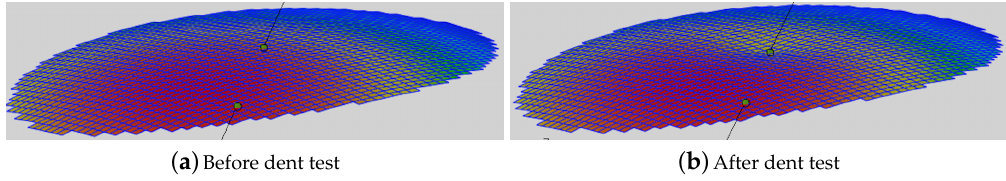
Figure 5. Visualisation of the dent depth with digital image correlation (DIC): pole geometry after bulging ( a ) and visualisation of the dent depth ( b ). This images correspond to the smallest pre-strain, with the permanent dent depth around